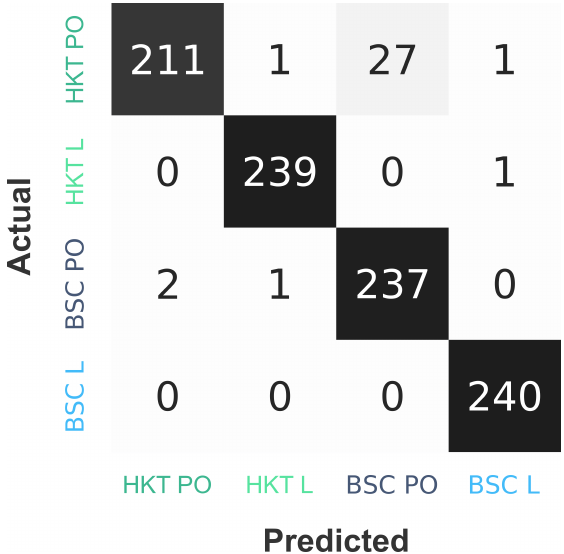
Figure 17. Multi-label confusion matrix (n = 960) without normalization for the four categories that have been used to train the neural